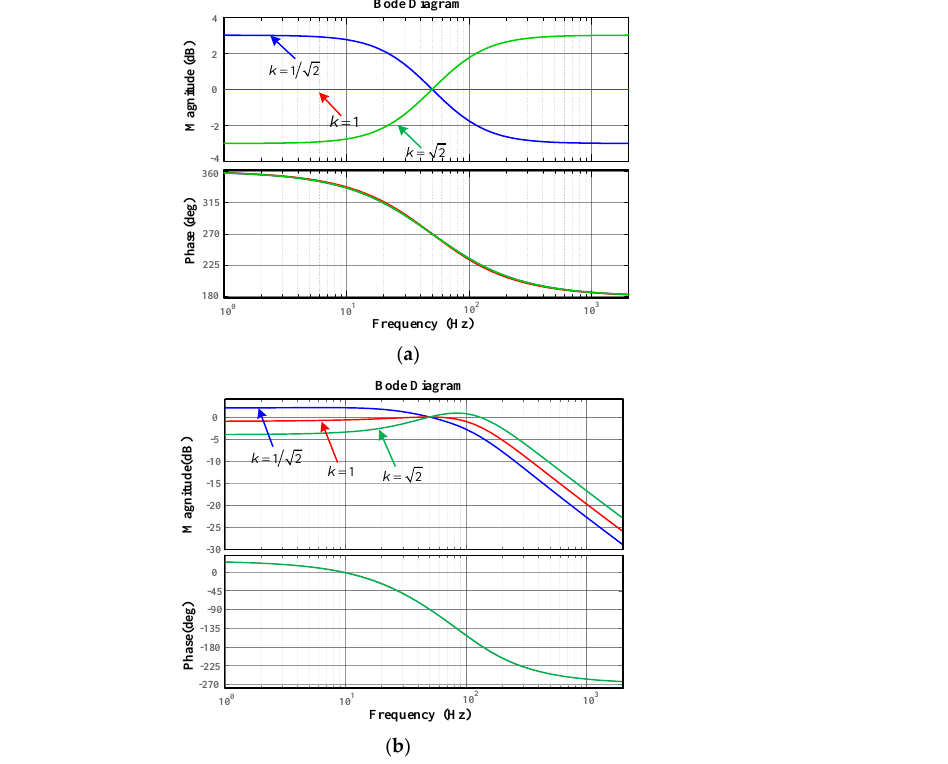
Frequency adaptive link Figure 6. Control diagram of CCF. Analyzing Figure 5, the transfer function of QSG of CCF-MFOF-PLL can be obtained as: